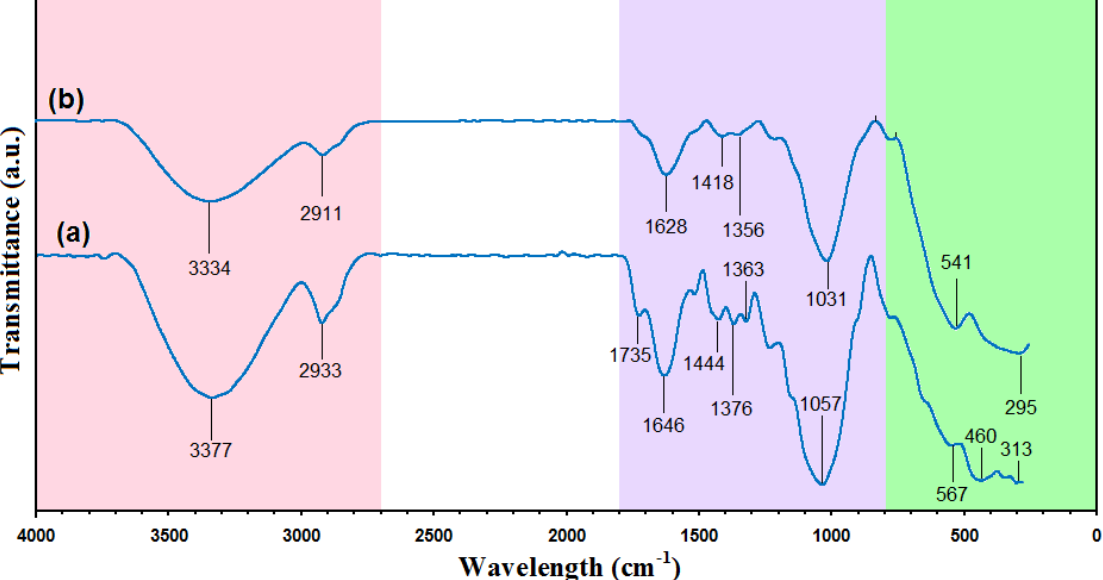
Figure 6. Fourier transforms infrared spectra of rice straw and rice straw/Fe